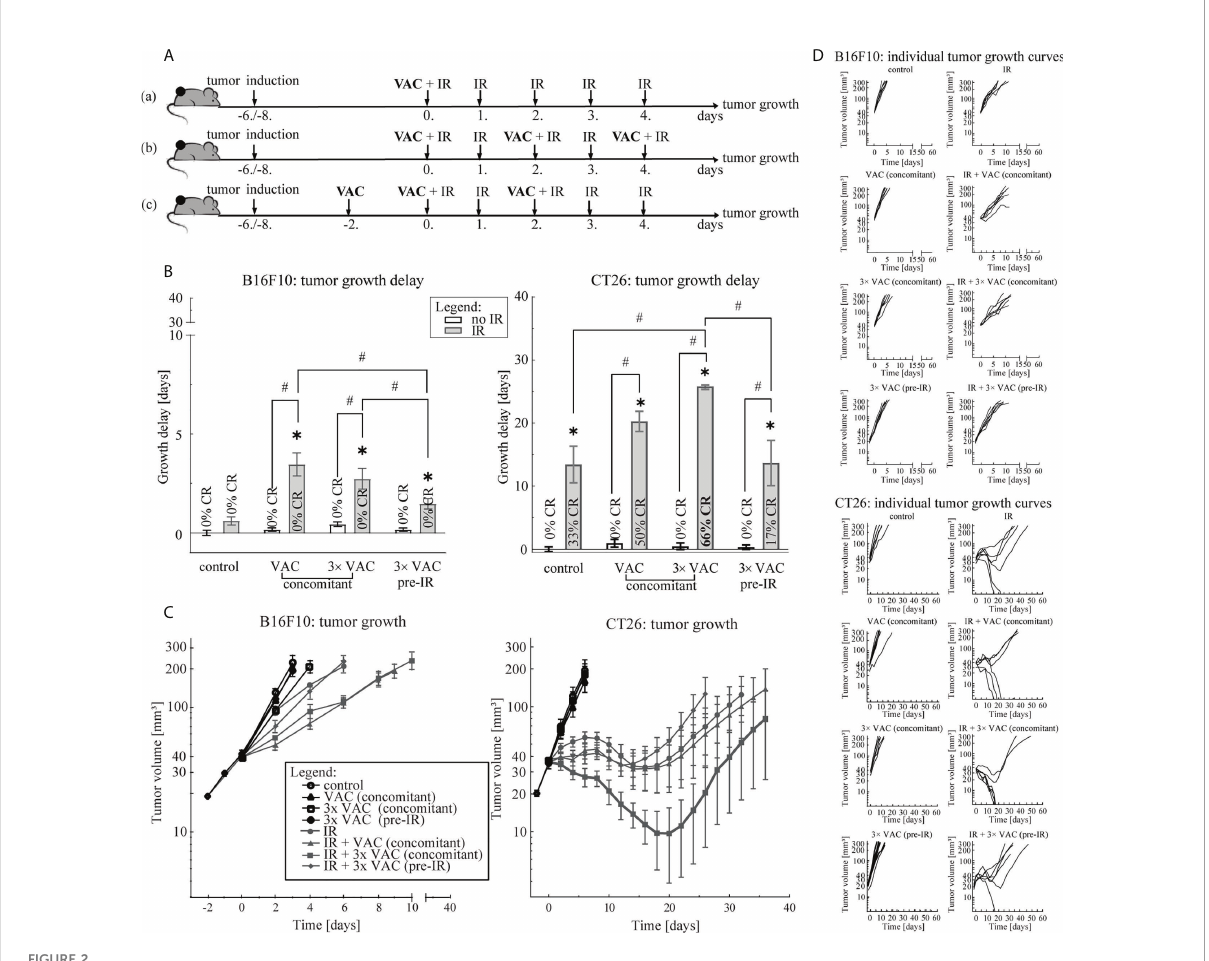
FIGURE 2 Vaccination regimen selection. (A) Treatment timelines: (a) concomitant single-dose vaccination combined with IR, (b) concomitant multi-dose vaccination combined with IR and (c) pre-IR vaccination combined with IR. (B) Tumor growth delay in the B16F10 (left) and the CT26 (right) tumor model. The legend applies to both graphs. (C) Tumor growth over time in the B16F10 (left) and in the CT26 (right) tumor model. The legend applies to both graphs. (D) Individual growth curves for each tumor of each treatment (control) group in the B16F10 (top) and the CT26 (bottom) tumor model. Legend: *p < 0.05 versus control group; # p < 0.05 between the annotated treatment groups; CR, complete response; VAC, single-dose vaccination; IR, selected 5× 5 Gy IR